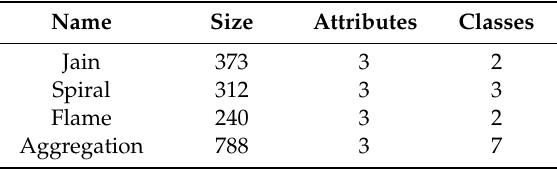
Table 1. Introduction of test data